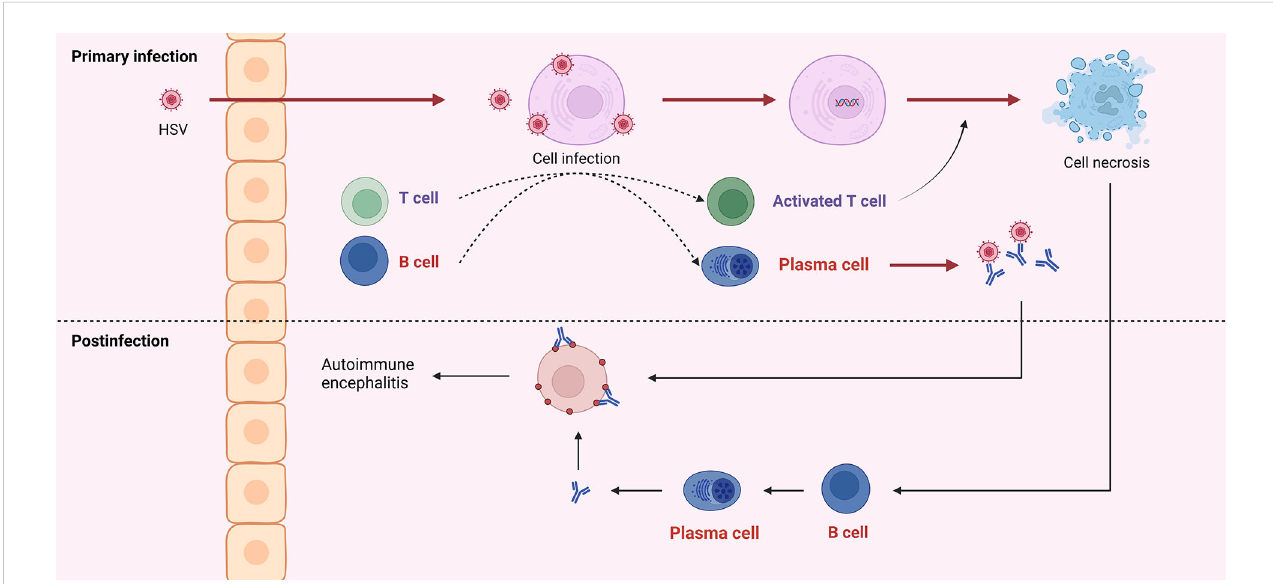
FIGURE 3 HSV into the central nervous system can cause infection of neurons, which is referred to as primary infection. Both viral particles and infected cells can recruit B and T cells. Antibodies produced by B cells can neutralize virus particles, and T cells can exert cytotoxicity to kill infected cells. Due to the similar structure of viral surface antigens to self-tissue, antibodies derived from the primary infection may attack healthy neurons. And cell disintegration leads to self-antigen exposure, induces B cells to produce antibodies, and further attacks self-cells, which is called post-infectious encephalitis or autoimmune